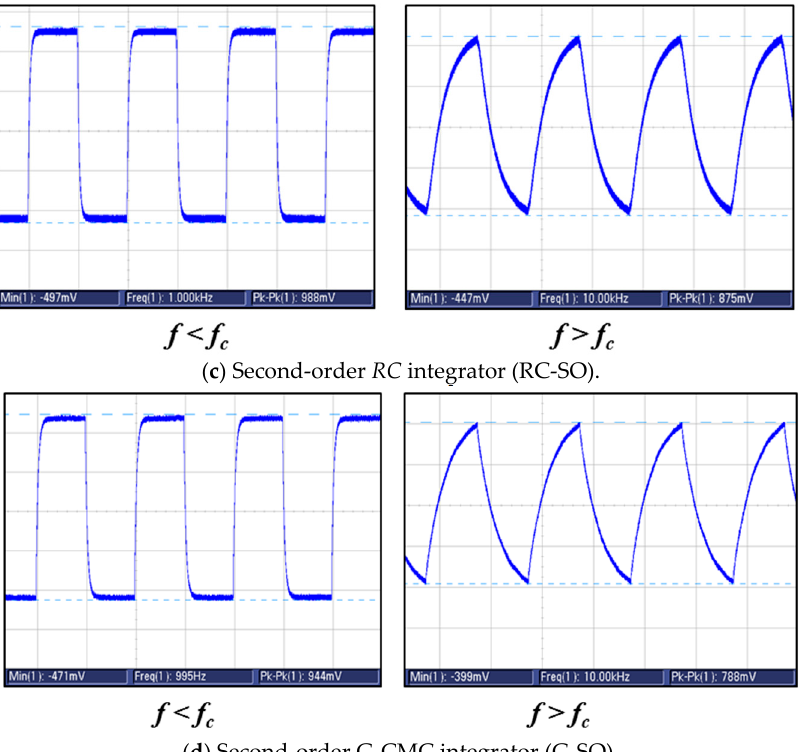
Figure 8. Comparison of transient response for ( a ) first-order RC integrator, ( b ) first-order G-CMC integrator, ( c ) second-order RC integrator, and ( d ) second-order G-CMC integrator. As expected, output signal was a square wave (left-side) below f c . Beyond f c , the signal was converted to a triangular wave (right-side).